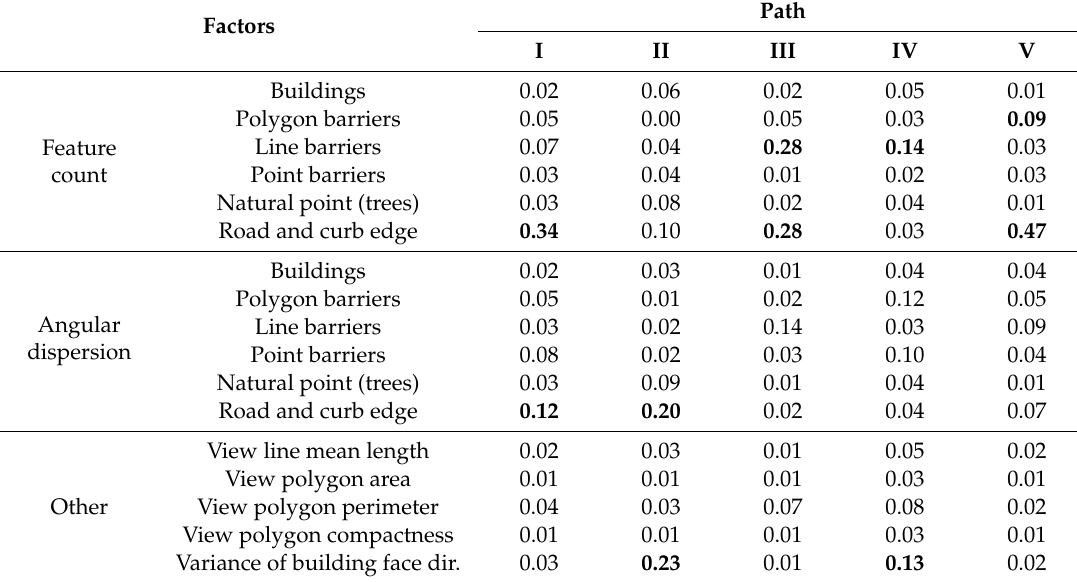
Table 9. Factor importance, individual paths. The two most important factors for each path are emphasized in